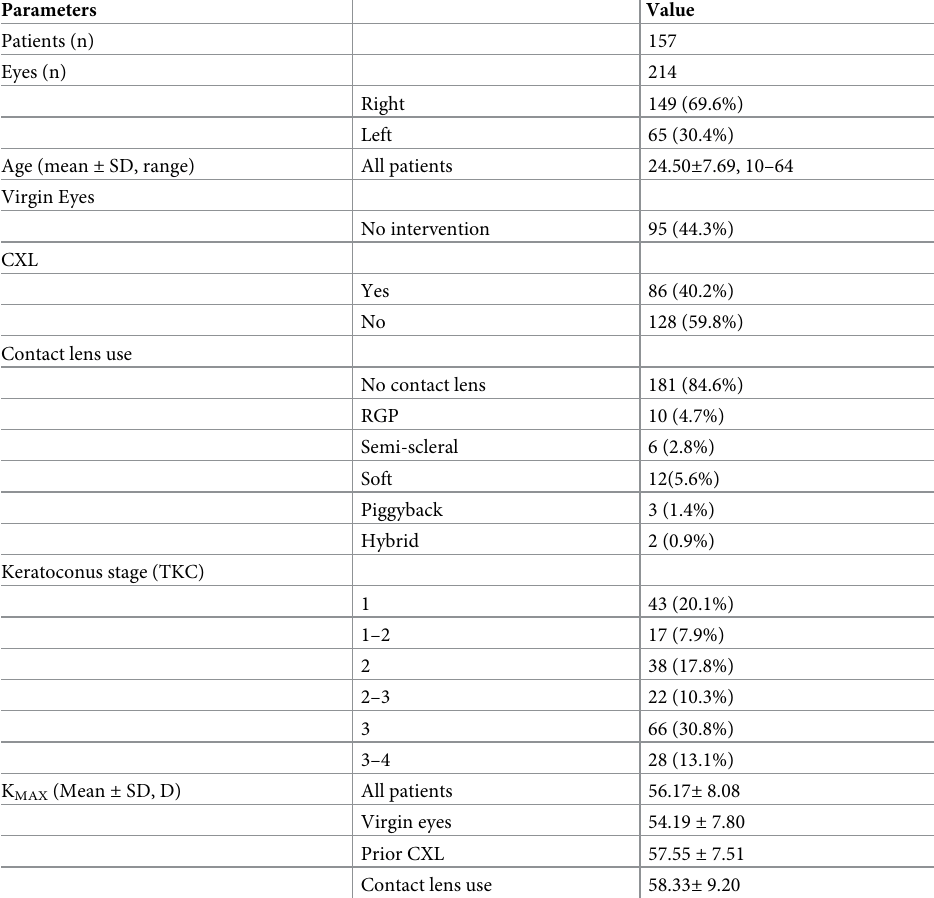
Table 1. Demographic information of all patients included in the